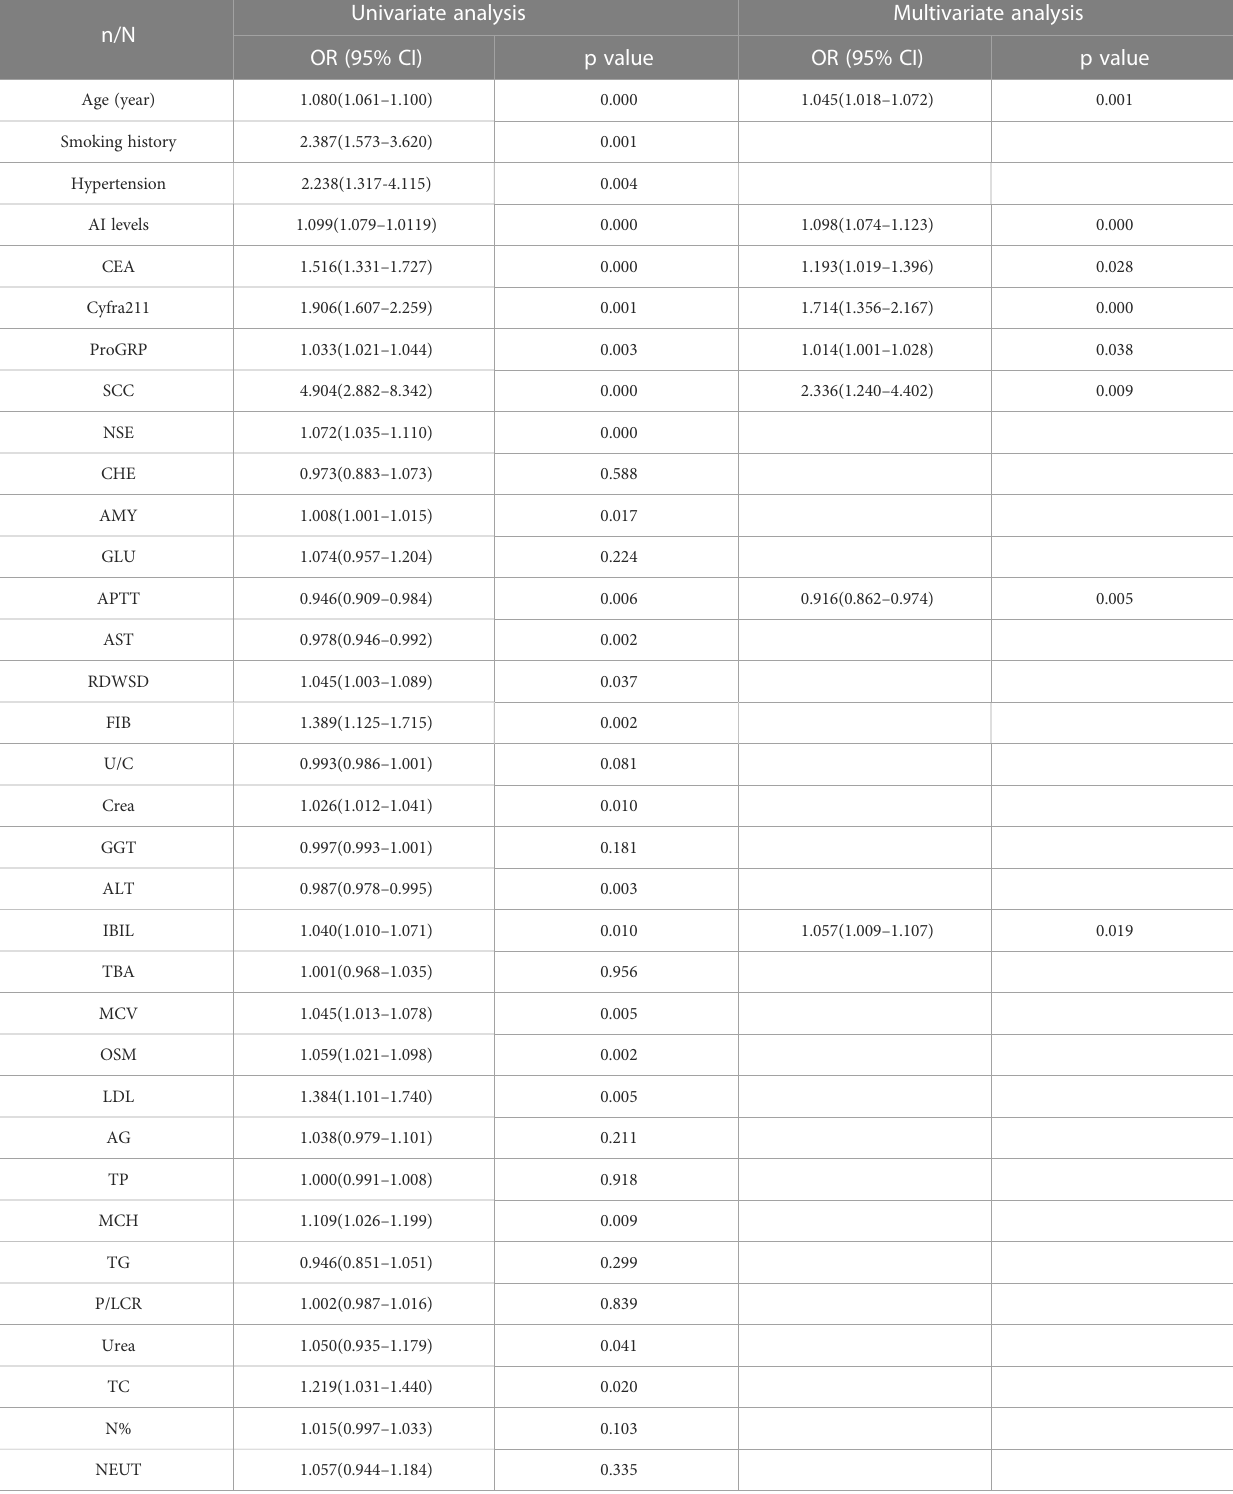
TABLE 2 Univariate and multivariate logistic regressions of risk factors for lung